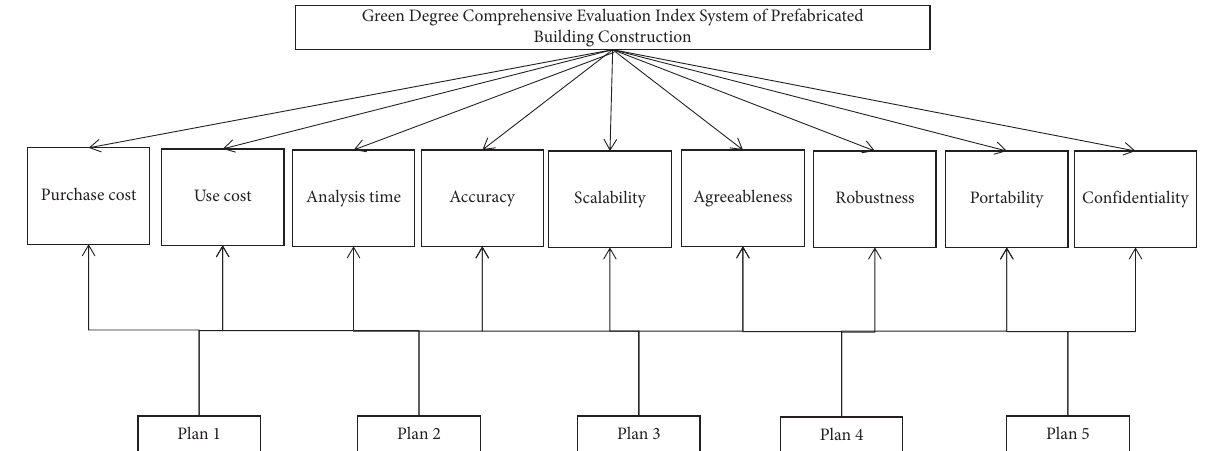
Figure 1: Green evaluation index system of prefabricated